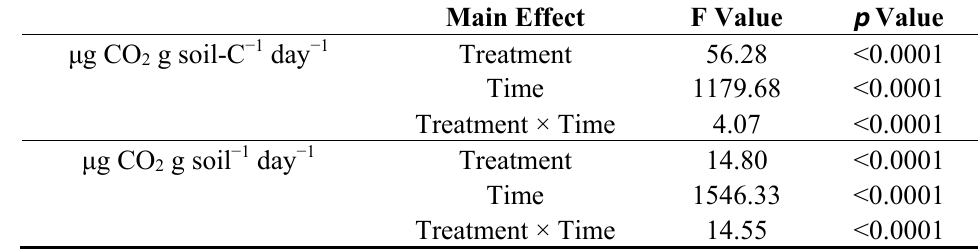
Table 2. Table of F-statistics and p -values for ANOVAs of soil respiration for treatment, time, and treatment × time. All PyC types and concentrations fall under